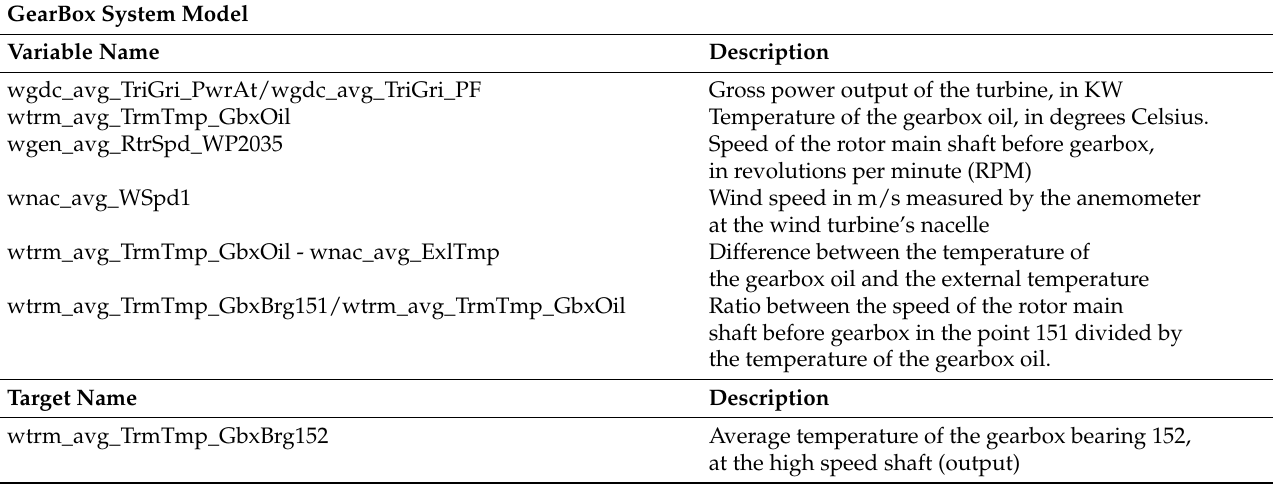
Table 2. The variables selected by an expert as being relevant for the gearbox operation. Note that to avoid a linear combination of the variables provided by the SCADA system, three variables are artificially generated.